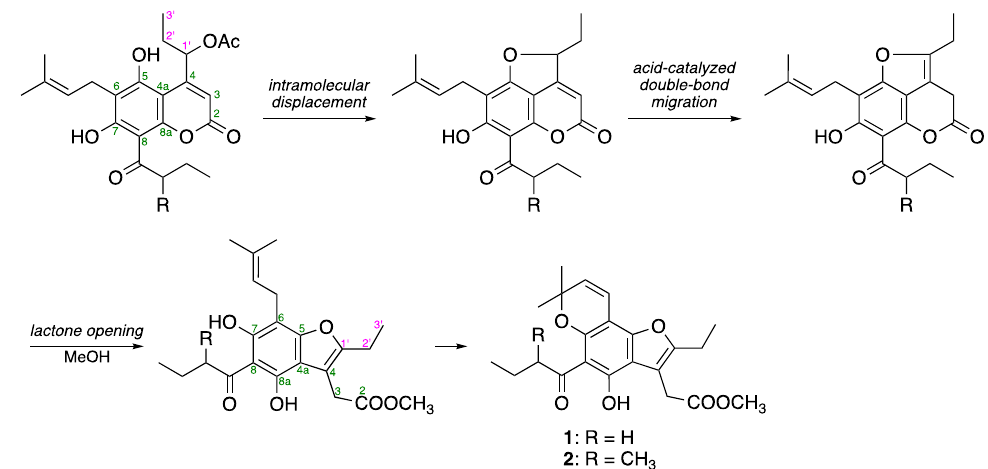
Figure 3. Plausible generative pathway of 1 and 2 .